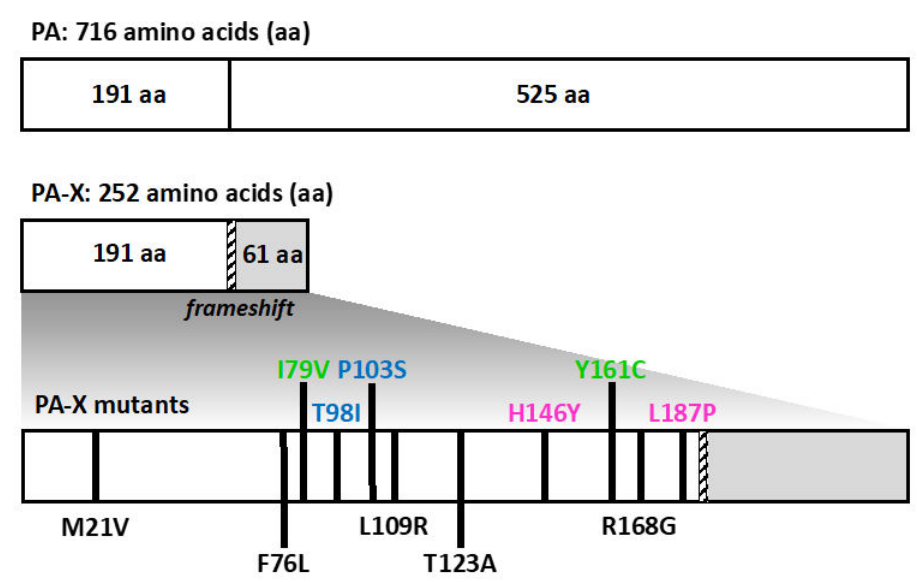
Figure 2. Schematic representation of 1918 PA and PA-X identified mutations: the PA-X protein is encoded from the viral PA segment using a +1 frameshift motif (striped bar). Using a bacteria-based assay, amino acid residues in 1918 PA-X involved in host shutoff were identified (black lines). PA-X clones containing a single mutation are indicated in black. PA-X clones containing double mutations are paired by either green, blue, or